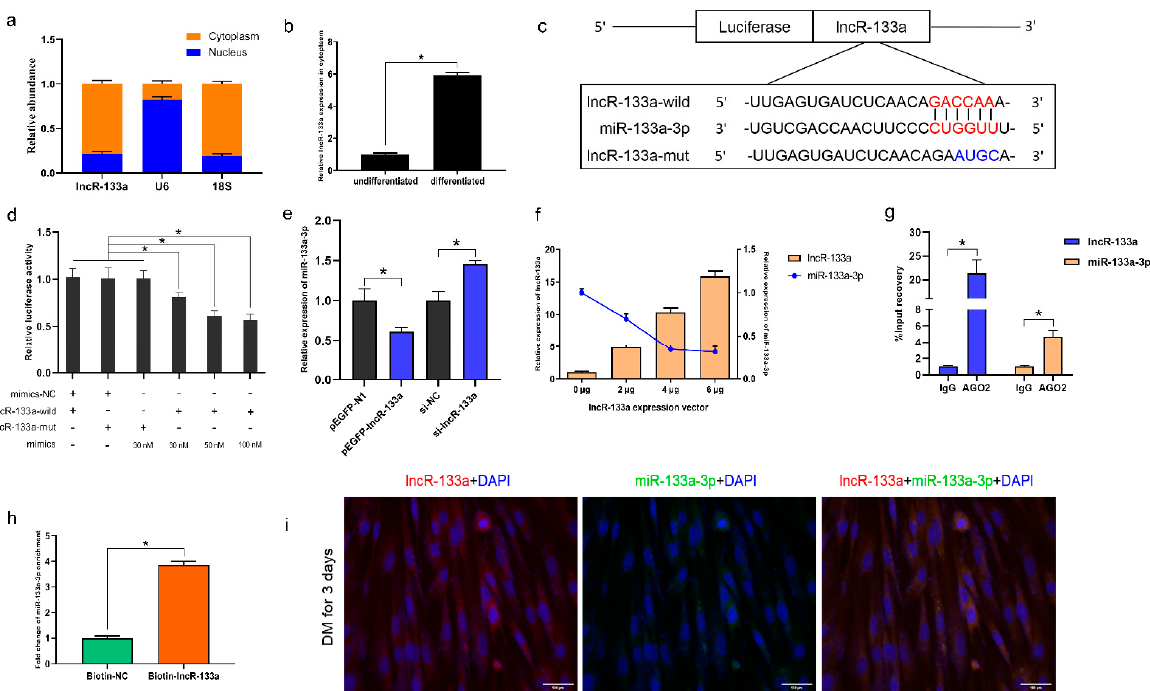
Figure 3. LncR-133a acts as a molecular sponge for miR-133a-3p. ( a ) The relative abundance of lncR-133a in the cytoplasm and nuclei of MuSCs differentiated for 3 days. 18S rRNA and U6 served as cytoplasmic and nuclear controls, respectively. ( b ) qRT-PCR analysis of lncR-133a level in the cytoplasm of undifferentiated MuSCs and MuSCs differentiated for 3 days. ( c ) Schematic diagram of a luciferase reporter containing lncR-133a wild type or mutant type of miR-133a-3p targeting site. The seed sequence for miR-133a-3p is displayed in red, whereas the mutant sequence for lncR-133a is indicated i in blue. ( d ) Luciferase assays demonstrated that miR-133a-3p inhibits the activity of lncR-133a. ( e ) qRT-PCR analysis of miR-133a-3p expression in MuSCs transfected with pEGFP-N1, pEGFP-lncR-133a, si-NC, and si-lncR-133a, respectively. ( f ) qRT-PCR evaluation of the expression levels of lncR-133a and miR-133a-3p in MuSCs transfected with increasing concentrations of lncR- 133a expression vector. ( g ) RIP assay was carried out using AGO2 antibody, with IgG as the negative control. ( h ) The expression of miR-133a-3p was measured after streptavidin capture in MuSCs (3 d) transfected with biotin-NC and biotin-lncR-133a. ( i ) Co-localization of lncR-133a and miR-133a-3p in MuSCs. RNA Dual-labeled Fluorescence in Situ Hybridization (FISH) assay was performed on MuSCs cultured for 3 d, using fluorescent oligonucleotide probes complementary to lncR-133a (red) and miR-133a-3p (green). Cell nuclei were visualized with DAPI staining (blue), Scale bars = 100 µ m. Data are means ± standard error of the mean of at least three biological replicates, * p <